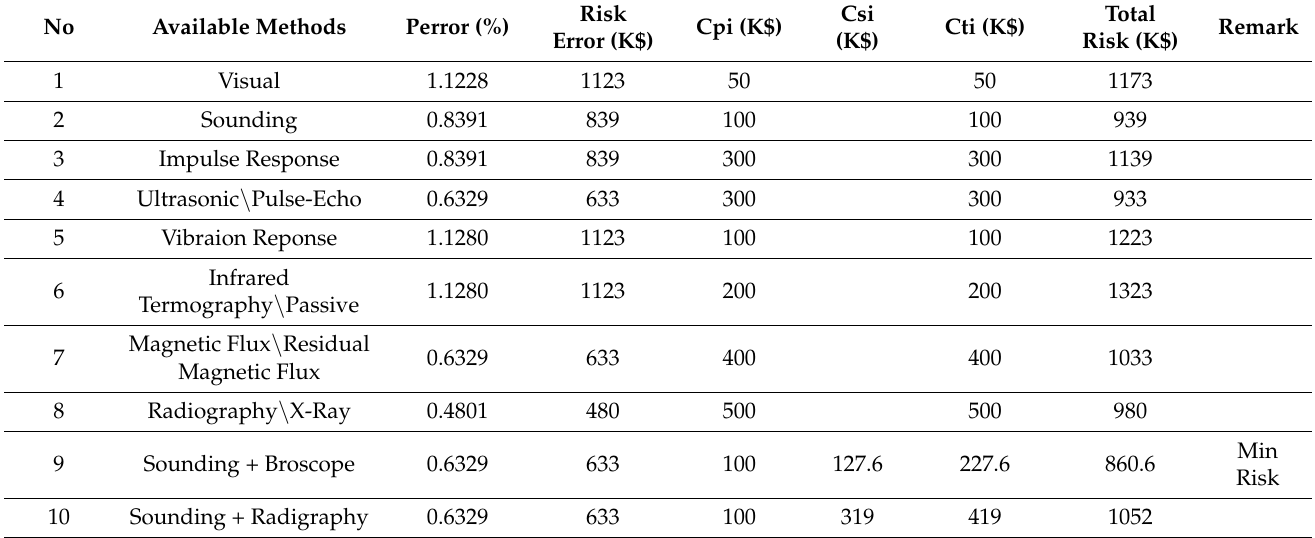
Table 5. Risk Analysis for Available NDE